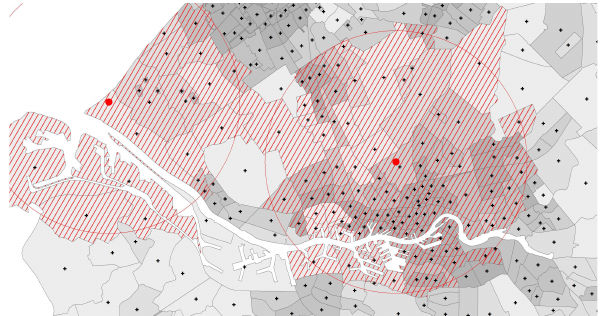
Fig. 2. Example to illustrate the subsetting of insurance data. The two red dots are rain gauges and the open circles the rain gauge ar- eas. The black crosses are the centroids of the districts. The shaded areas are the districts that have been